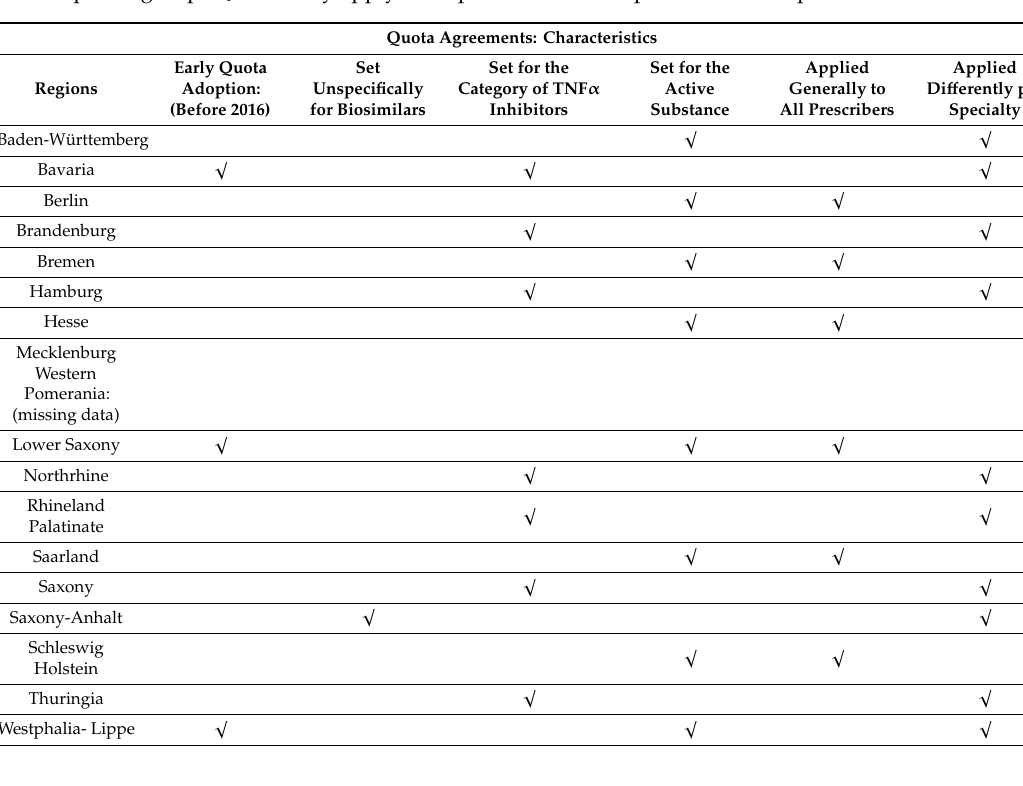
Table 3. Comparative analysis of regional quota agreements for TNF α inhibitors, based on information available on the websites of the 17 German PA regions [31–47]. Quotas were set either generally for biosimilars or more specifically for the therapeutic group or for each of the active substances within the therapeutic group. Quotas may apply to all prescribers or to specific medical